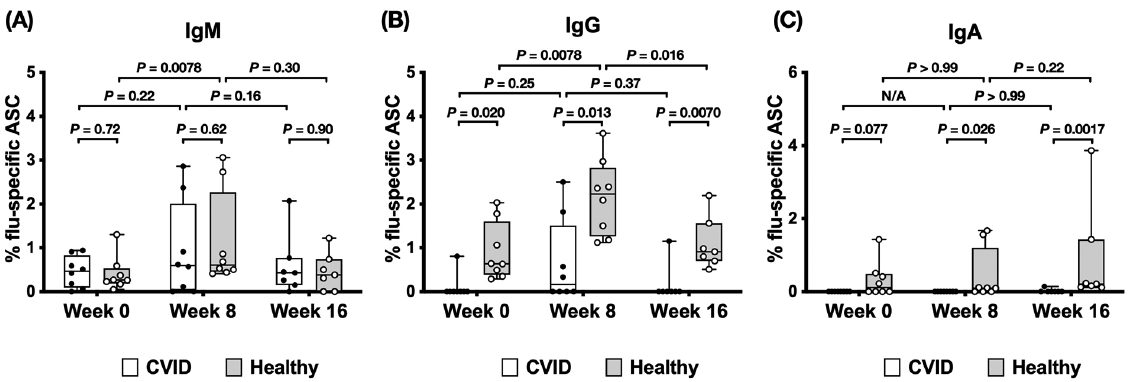
Figure 4. Influenza-specific B-cell ELISpot response in patients with CVID and healthy participants. PBMCs were collected at the time of vaccination (week 0) and subsequently at week 8 and week 16 post- vaccination. Cells were stimulated by CpG and heat-killed bacteria for 4 days to allow the memory B cells to differentiate into antibody-secreting cells (ASCs), then plated on an ELISpot plate pre-coated with either vaccine HA, keyhole limpet hemocyanin (control antigen, not shown), or anti-Ig Lambda/anti- Ig Kappa (not shown). After 12 hours, the plates were washed and processed for spot development. The number of spots in the HA well divided by the number of spots in the anti-Ig Lambda/anti-Ig Kappa well was calculated for determining the frequency of influenza-specific ASCs as a percentage of total